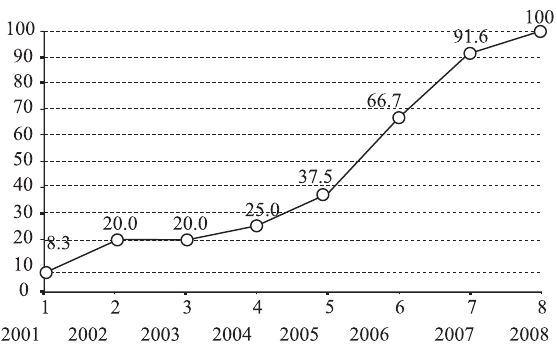
Fig. 1. Dynamics in the construction of roundabouts on the Lithuanian rural roads of national significance in 2001–2008 solute frequency histogram and empirical distribution function of outer radius of roundabouts are given in Fig. 3.